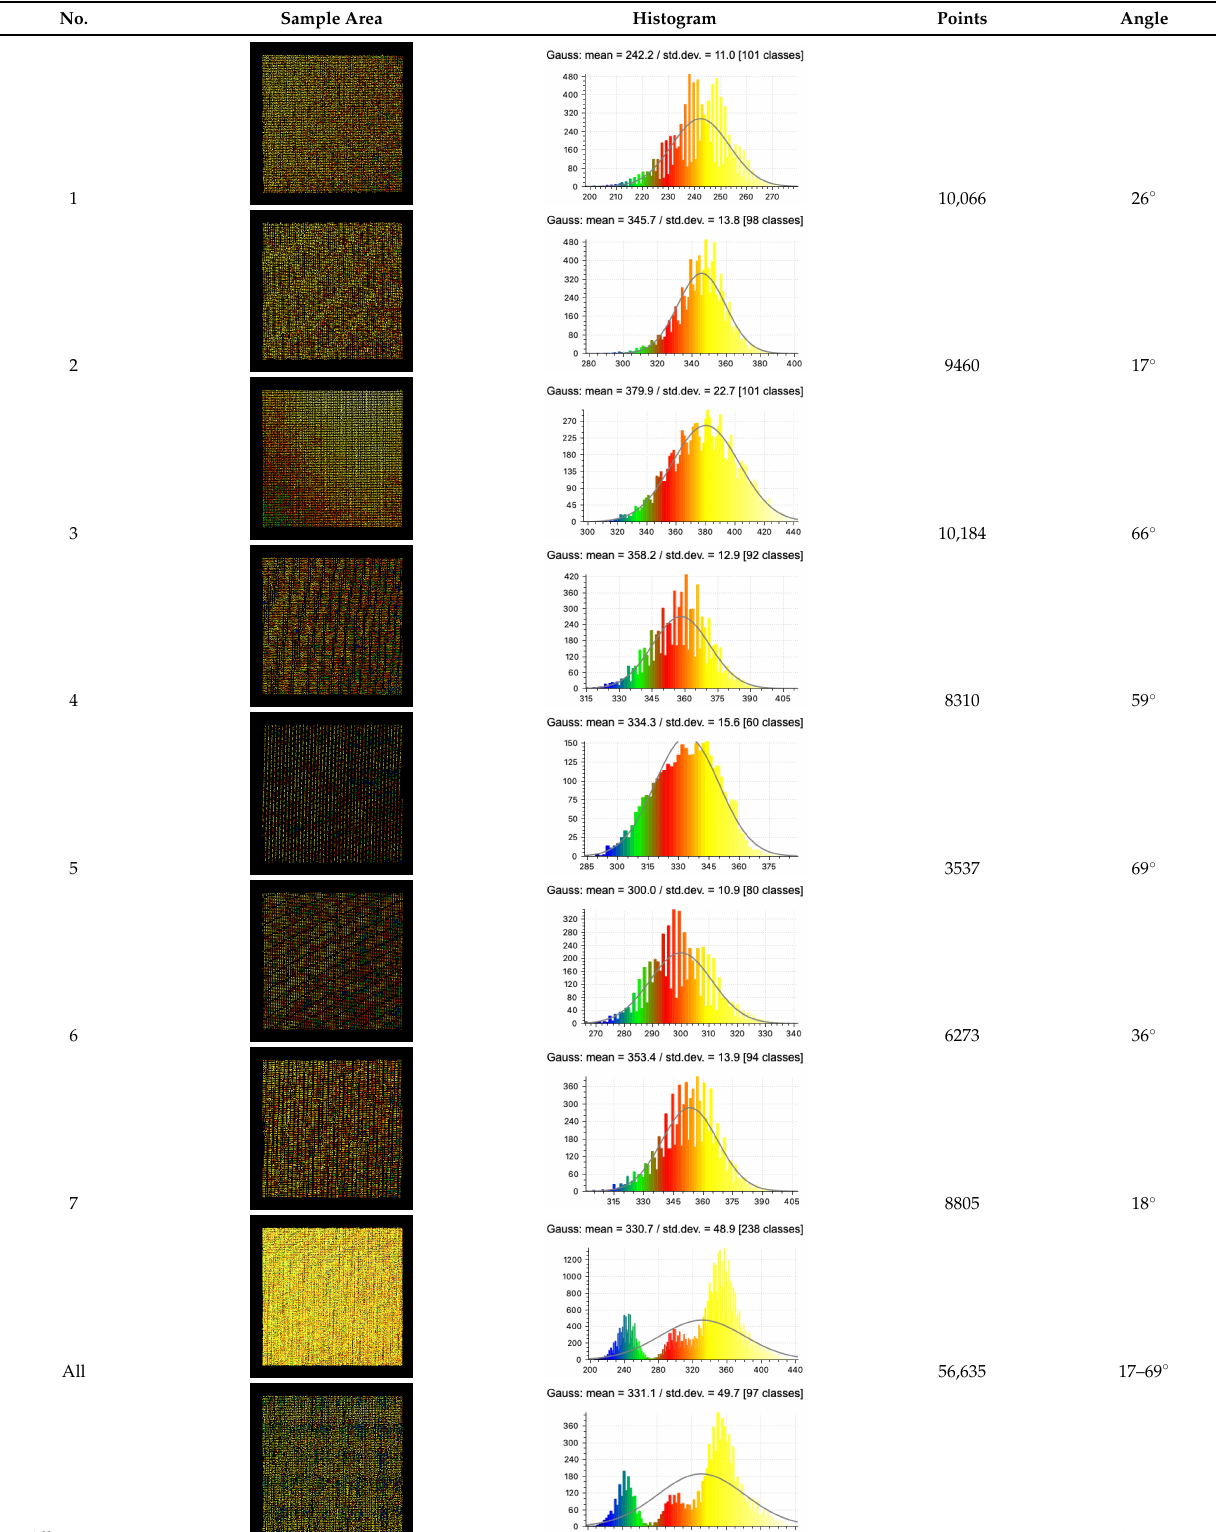
Table A4. The vertical sample area: included scans (single scan stations “1–7”, merged scans “All”, and the merged scan subsampled with octree level 12), sample area visualization, histogram of luminances, number of points, and angle between the surface normal and the measurement